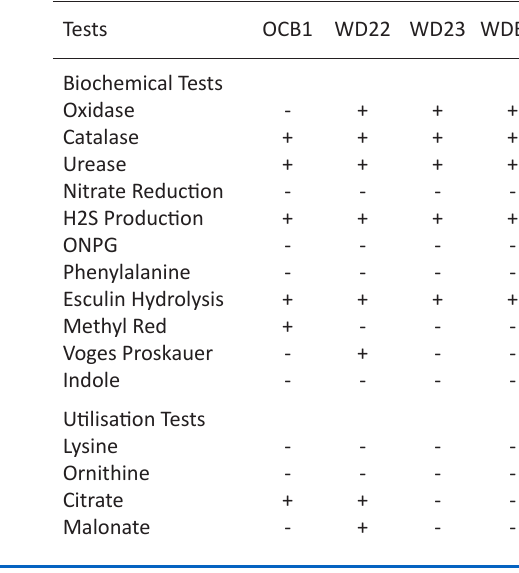
Table 6. Biochemical characterisation of isolated